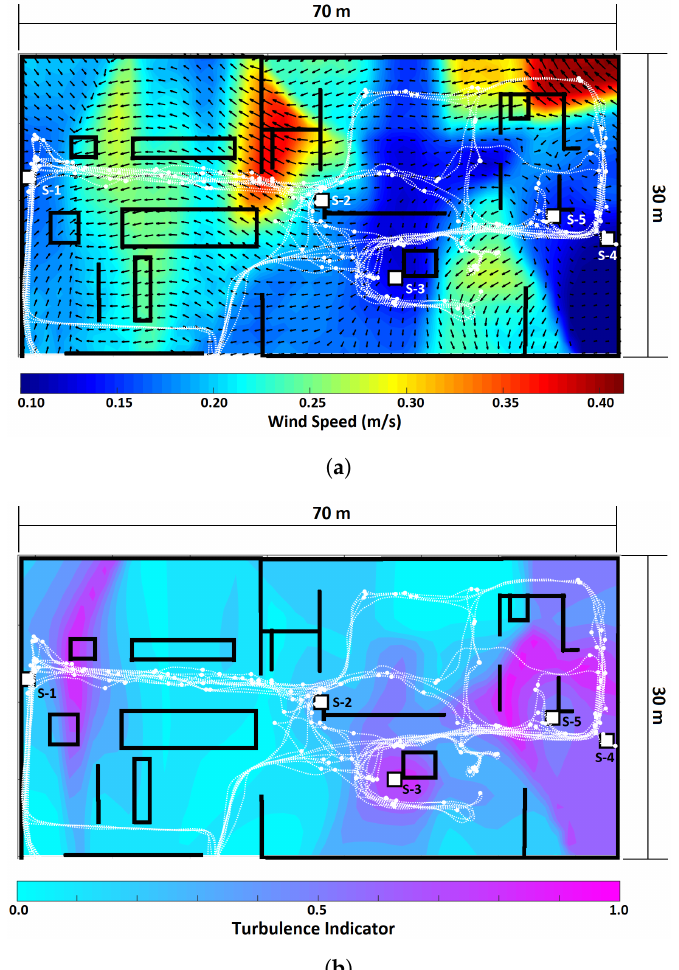
Figure 10. Ventilation maps for foundry-A. ( a ) Expected wind map, where the arrows indicate the wind direction while the color code denotes the wind speed. ( b ) Turbulence